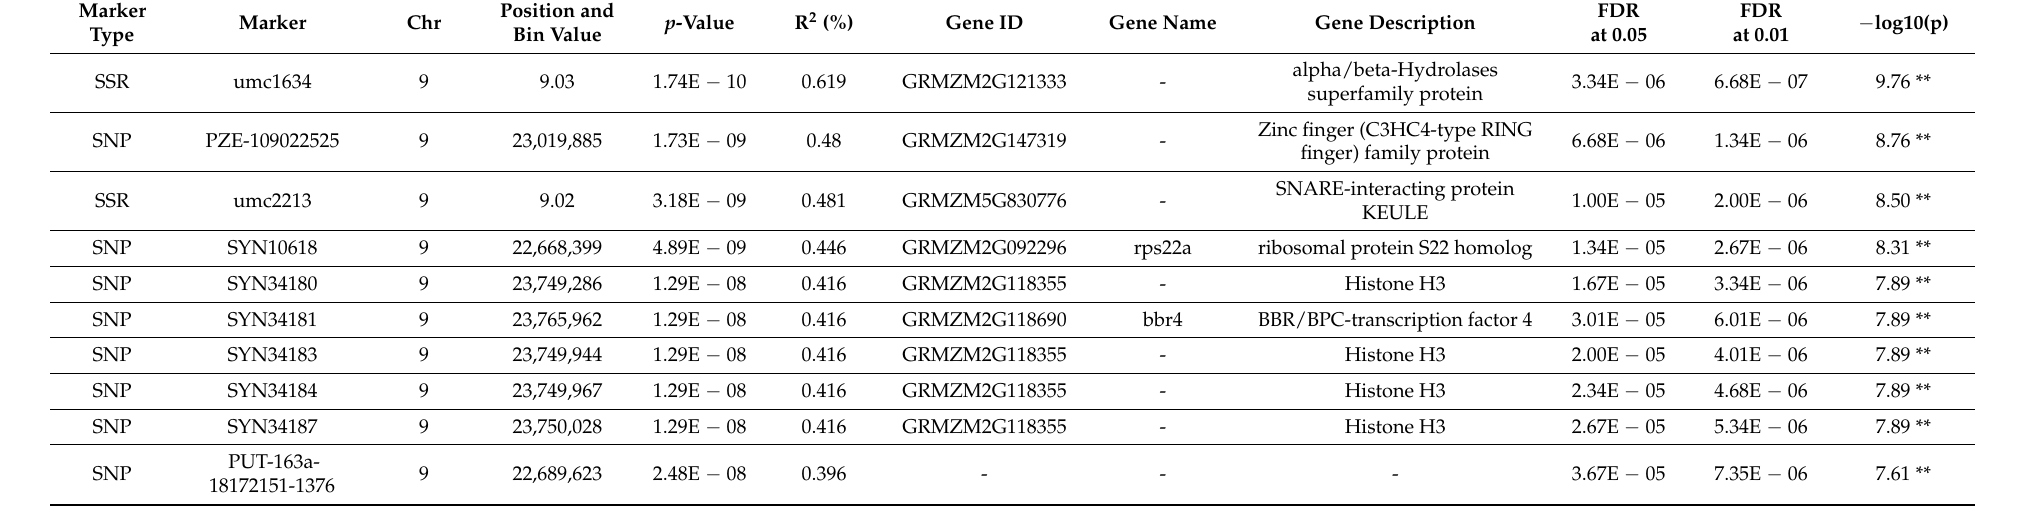
Table 3. Information of marker–trait association for amylose content using PCA + K